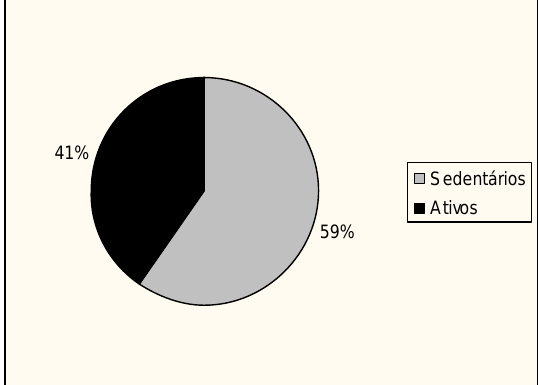
Figura 1. Classificação do nível de AF no lazer dos